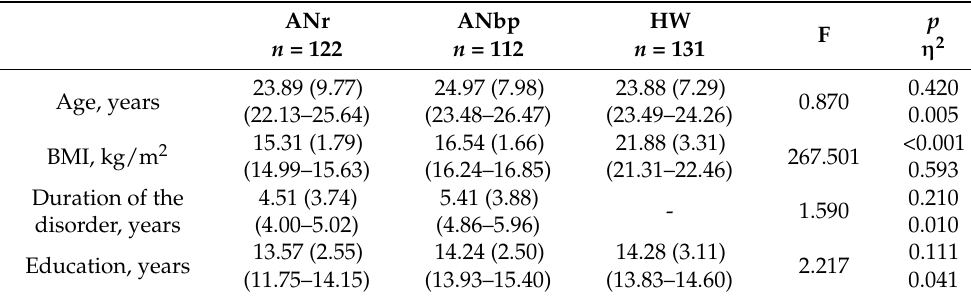
Table 1. Demographic description of the